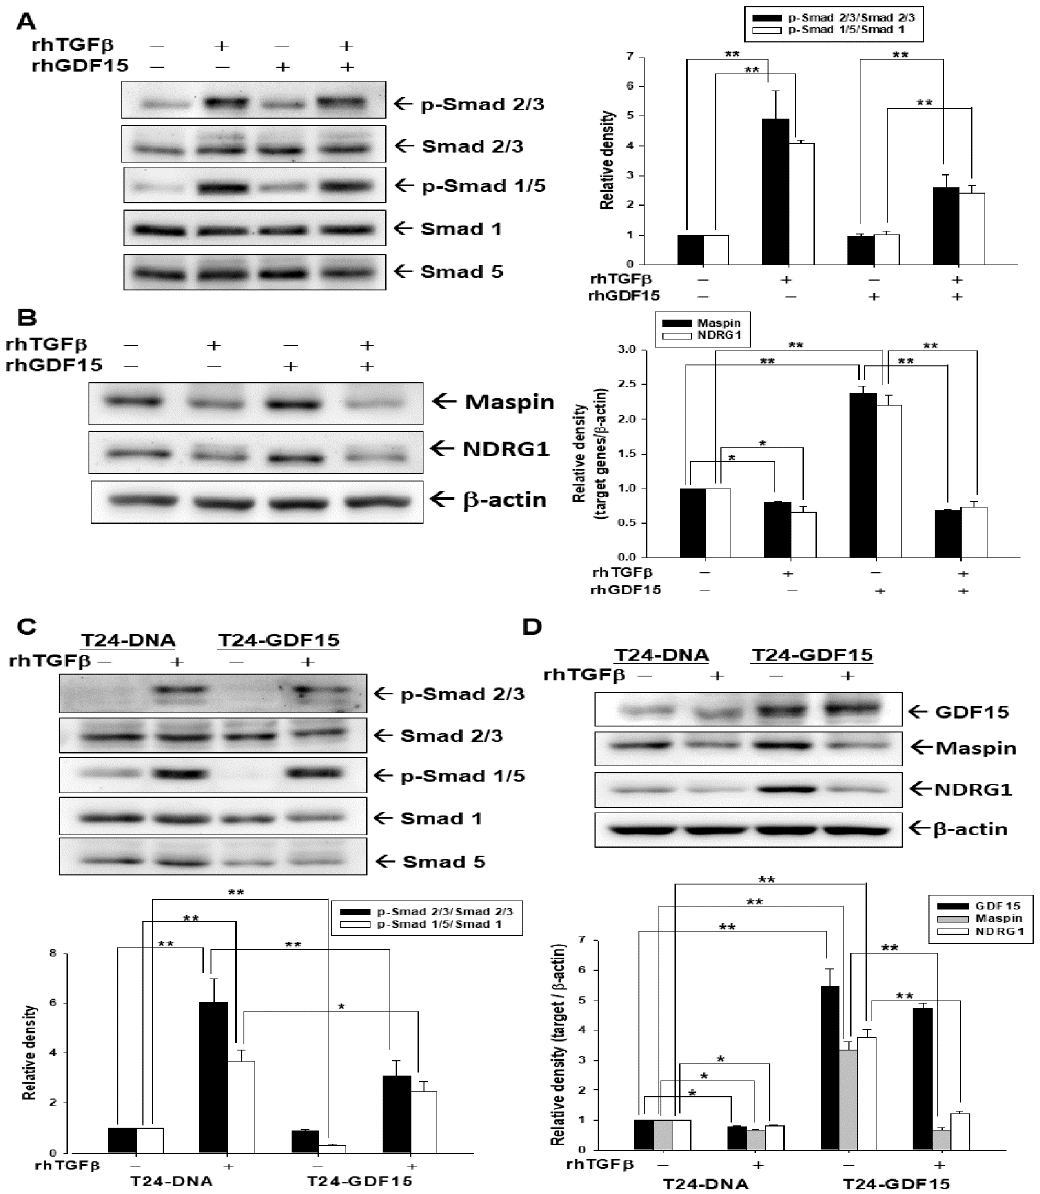
Figure 3. GDF15 inhibits the effect of TGFβ on Smas signaling activation and the expressions of GDF15, maspin, and NDRG1 in bladder carcinoma cells. The expressions of Smad 2/3, p-Smad 2/3, Smad 1, Smad 5, and p-Smad 1/5 were determined using immunoblot assays (( A ), left) and quanti- tative analysis (( A ), right) after treated with (+) or without ( − ) 10 ng/mL rhTGF β and 400 ng/mL rhGDF15 as indicated for 1h in T24 cells. The expressions of maspin, NDRG1, and β -actin were determined using immunoblot assays (( B ), left) and quantitative analysis (( B ), right) after being treated with (+) or without ( − ) 10 ng/mL rhTGF β and 400 ng/mL rhGDF15 as indicated for 18 h in T24 cells. The expressions of Smad 2/3, p-Smad 2/3, Smad 1, Smad 5, and p-Smad 1/5 were deter- mined using immunoblot assays (( C ), top) and quantitative analysis (( C ), bottom) after being treated with (+) or without ( − ) 10 ng/mL rhTGF β as indicated for 1 h in T24-DNA and T24-GDF15 cells. The expressions of maspin, NDRG1, and β -actin were determined using immunoblot assays (( D ), top) and quantitative analysis (( D ), bottom) after treated with (+) or without ( − ) 10 ng/mL rhTGF β and 400 ng/mL rhGDF15 as indicated for 18 h in T24-DNA and T24-GDF15 cells. The quantitative data were expressed as the intensity of protein bands of the p-target gene/target gene or target genes/β - actin relative to the control solvent-treated group ( n = 3). * p < 0.05, ** p < 0.01.